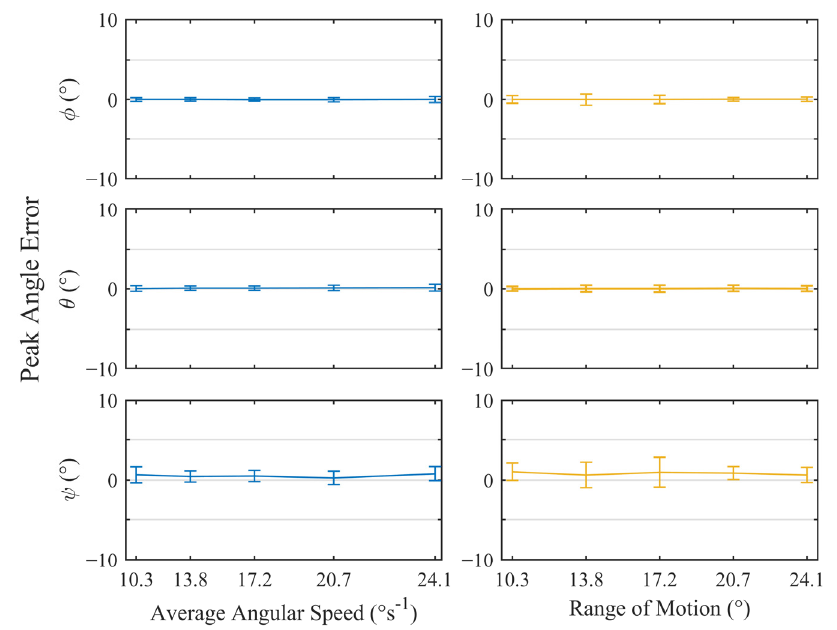
Figure 7. Plots of the mean angular error ± standard deviation for all peaks across n = 5 trackers, while undergoing test motions under ideal conditions. The left- and right-hand plots illustrate variation of error with respect to average angular speed and range of motion, respectively.